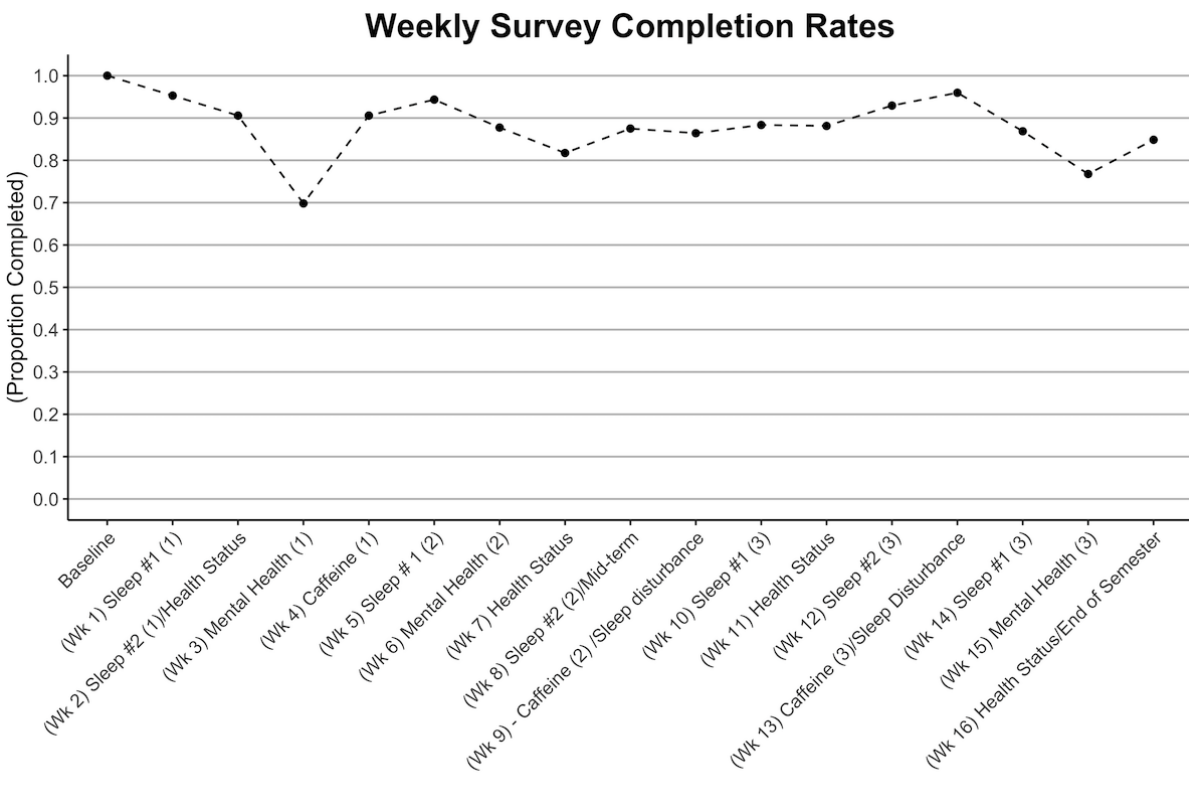
Figure 3. Weekly survey completion rate for Fall 2019 semester for Apple Watch